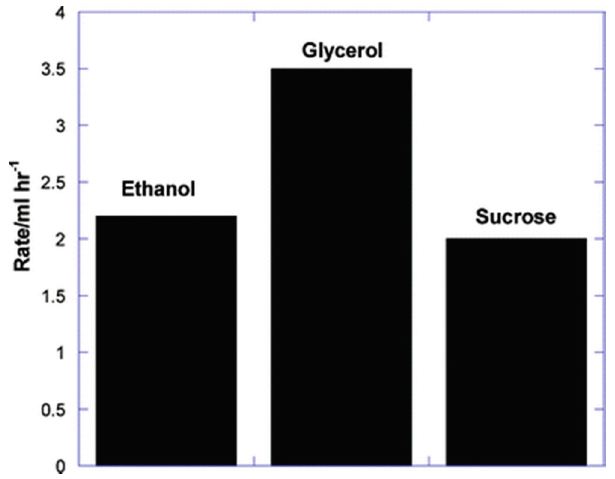
Figure 24. Rate of H 2 evolution by photo reforming of 3 important bio-oxygenates (1% in